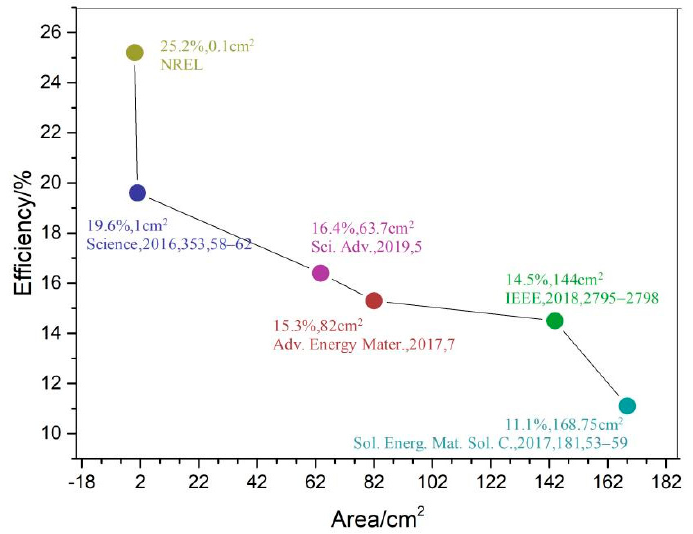
Figure 3. Relationship between power conversion efficiency (PCE) and device active area.